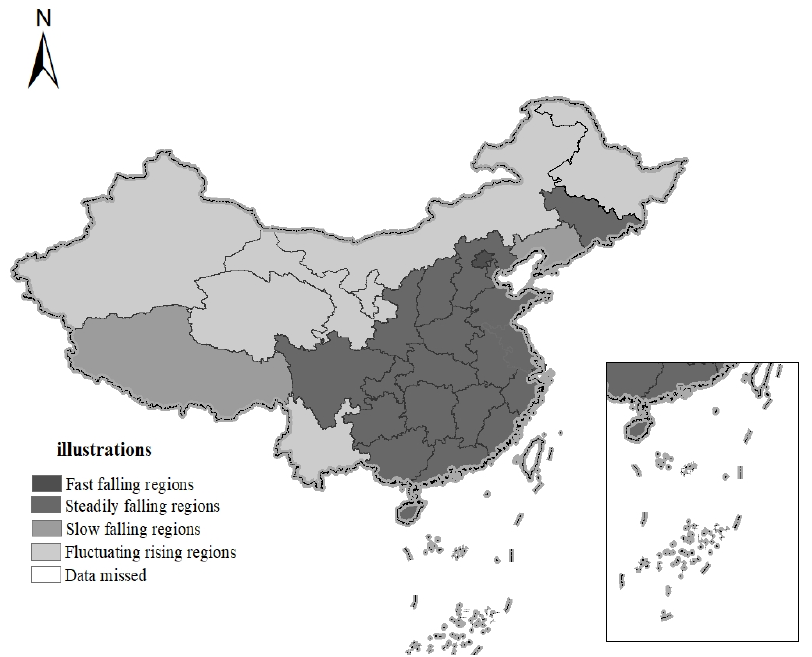
Figure 3. Regional distribution of different types of CO 2 eq emissions changes from animal husbandry in China from 2001 to 2019. Note: This map is based on the standard map downloaded from the standard map service website of the National Bureau of Surveying, Mapping, and Geographic Information with the approval number GS (2016)2556. The base map has not been modified. To analyze how the combined effects of various factors have led to the difference in teh rates of change in different provinces, based on the panel data of the total CO 2 eq emissions from animal husbandry in each province from 2001 to 2019, we used the multiplicative decomposition method to analyze the driving effects in 31 provinces, as shown in Table 5: Table 5. Decomposition of the driving factors of each province from 2001 to 2019 (%).